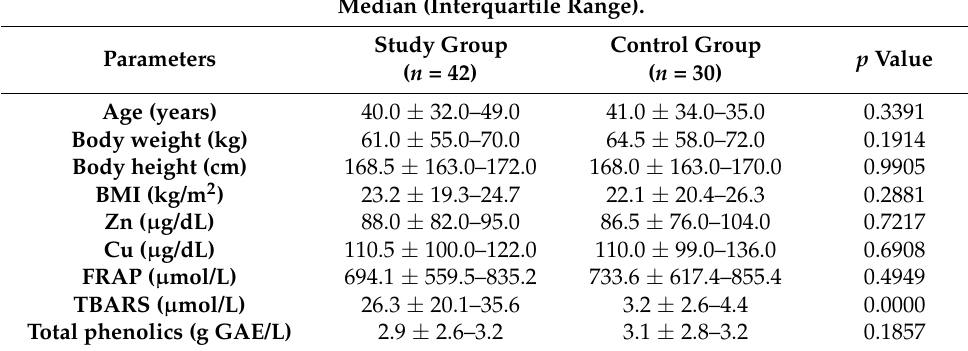
Table 1. Anthropometric characteristics and comparison of zinc and copper levels and antioxidant potential in women’s serum. Median (Interquartile